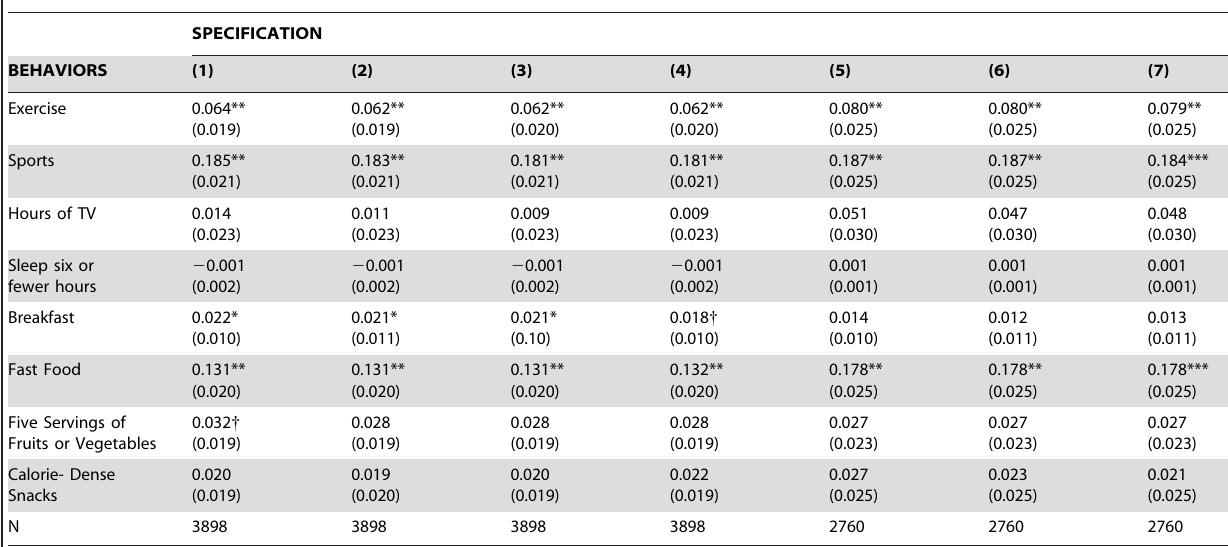
Table 4. Estimated Friendship Network Effects (with school–level Fixed Effects).